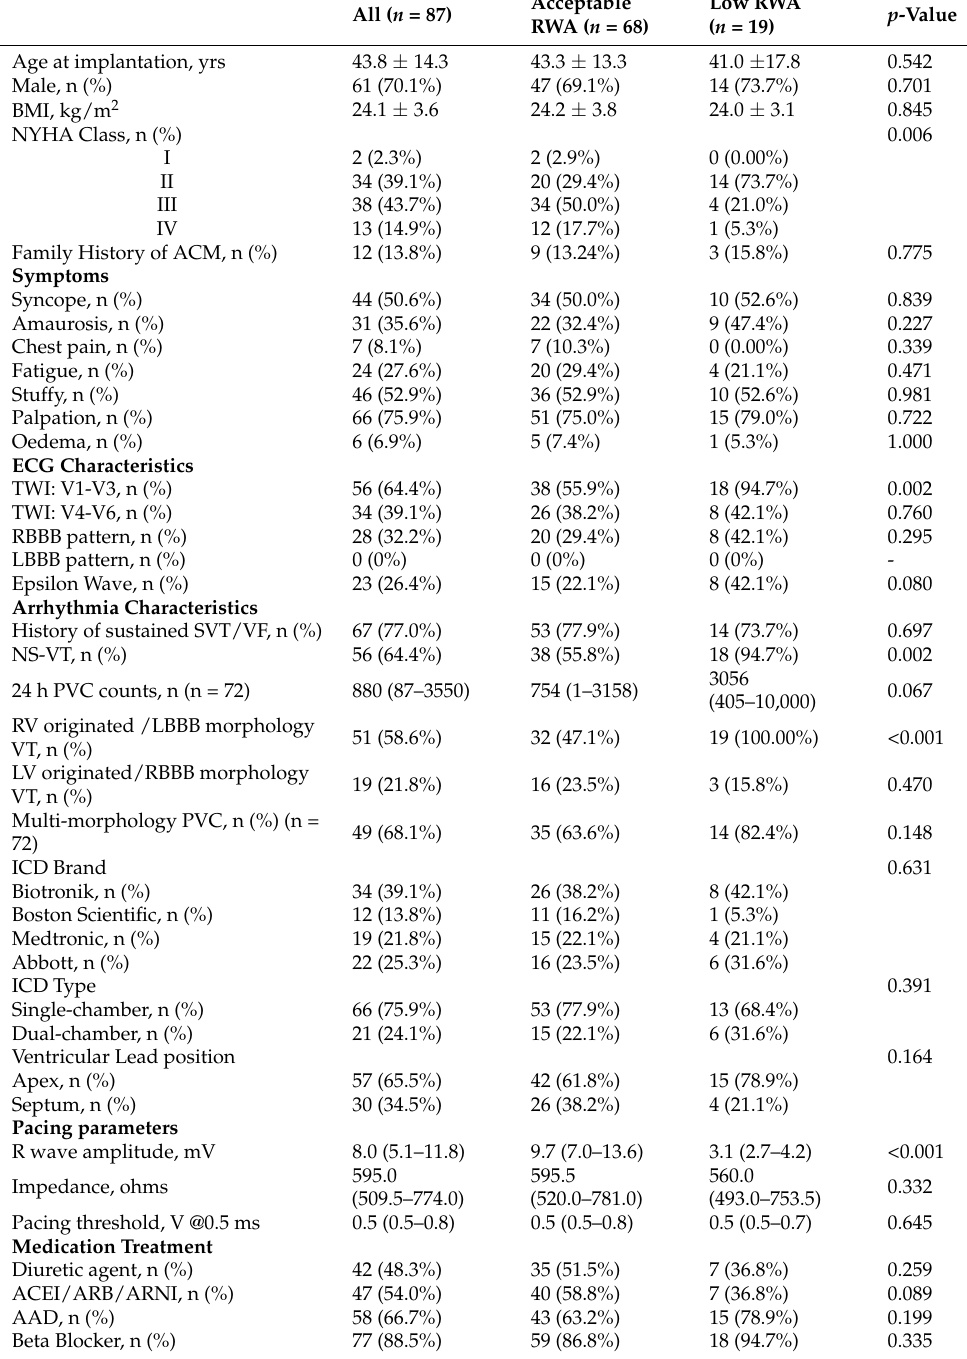
Table 1. Baseline features and ICD parameters of ACM patients with and without low